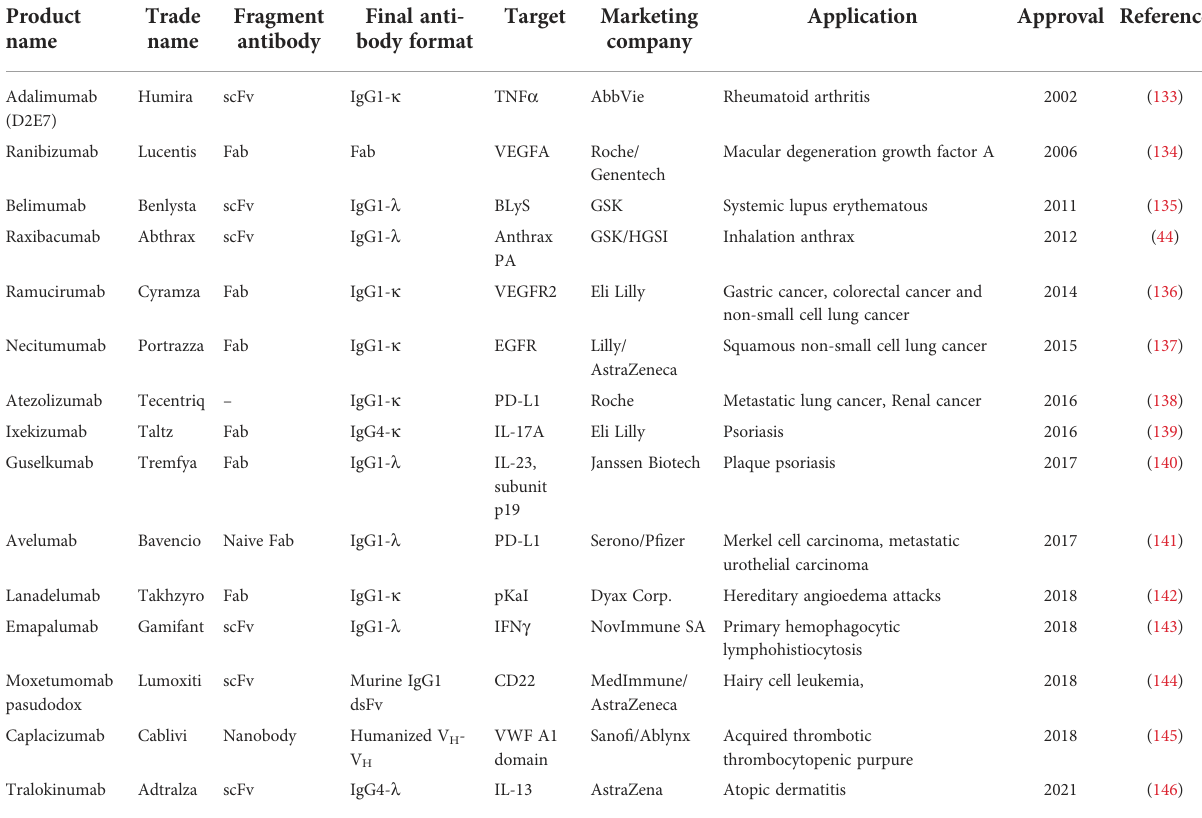
TABLE 1 FDA-approved human mAbs derived from phage display